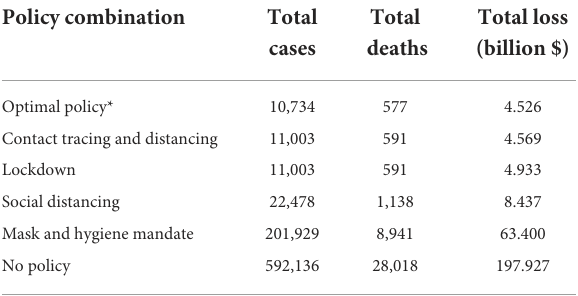
TABLE 3 Loss regarding some applied policies, full results are available in our